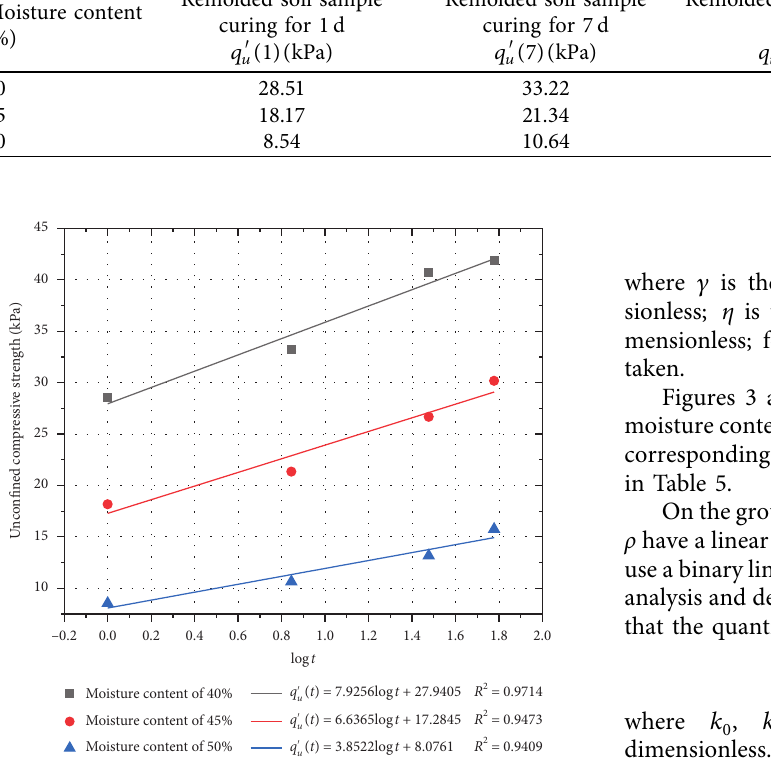
Figure 2: Relation curve q moisture content.